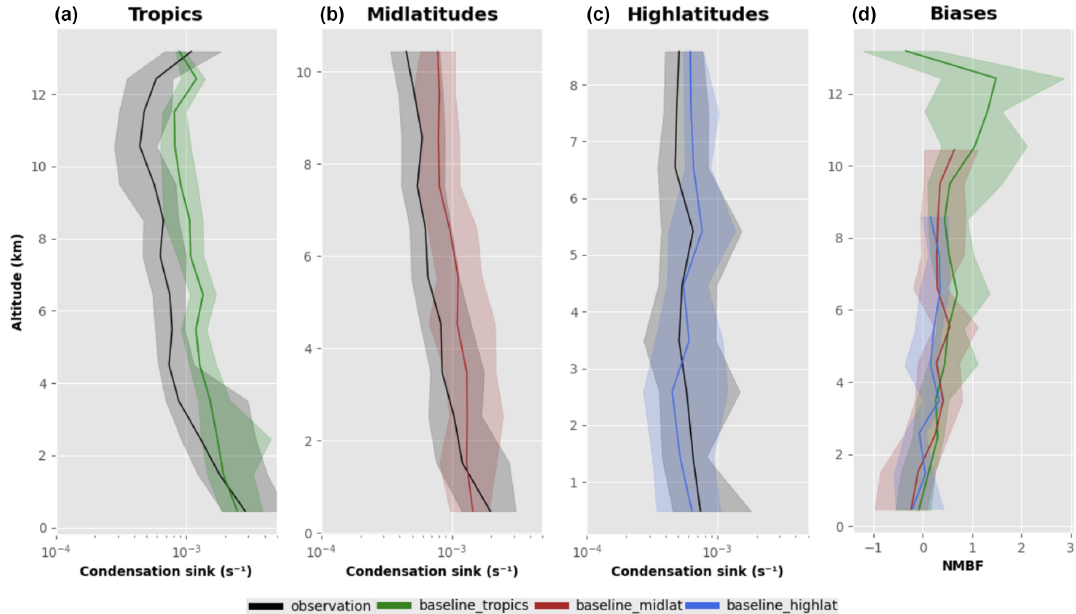
Figure 5. The first three columns show the vertical profile of the condensation sink (at STP) as observed (ATom1–4) and in the simulated data from the baseline (bug-fixed) configuration of UKESM in the tropics (25 ◦ N–25 ◦ S), mid latitudes (25–60 ◦ N and 25–60 ◦ S) and high latitudes (60–90 ◦ N and 60–90 ◦ S). The fourth column shows the NMBF of the baseline simulation in the tropics, mid latitudes and high latitudes. The bold line represents the median and the shaded region represents the corresponding interquartile range (25th and 75th percentiles) in a 1km altitude bin.